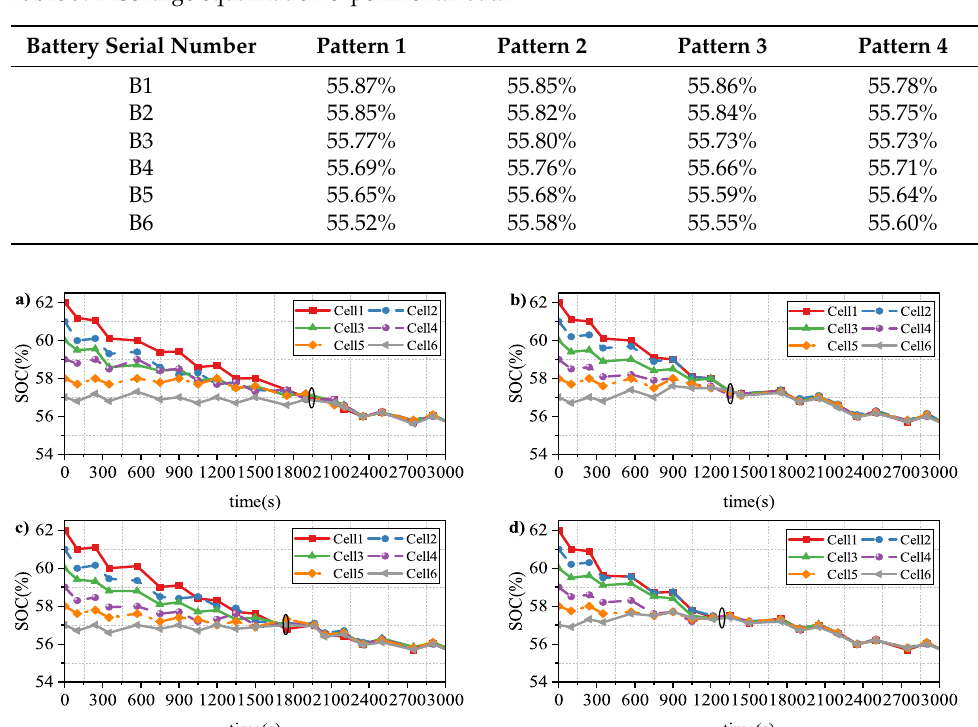
Figure 20. Discharge equalization process under dynamic DST condition: ( a ) Pattern 1; ( b ) Pattern 2; ( c ) Pattern 3; and ( d ) Pattern